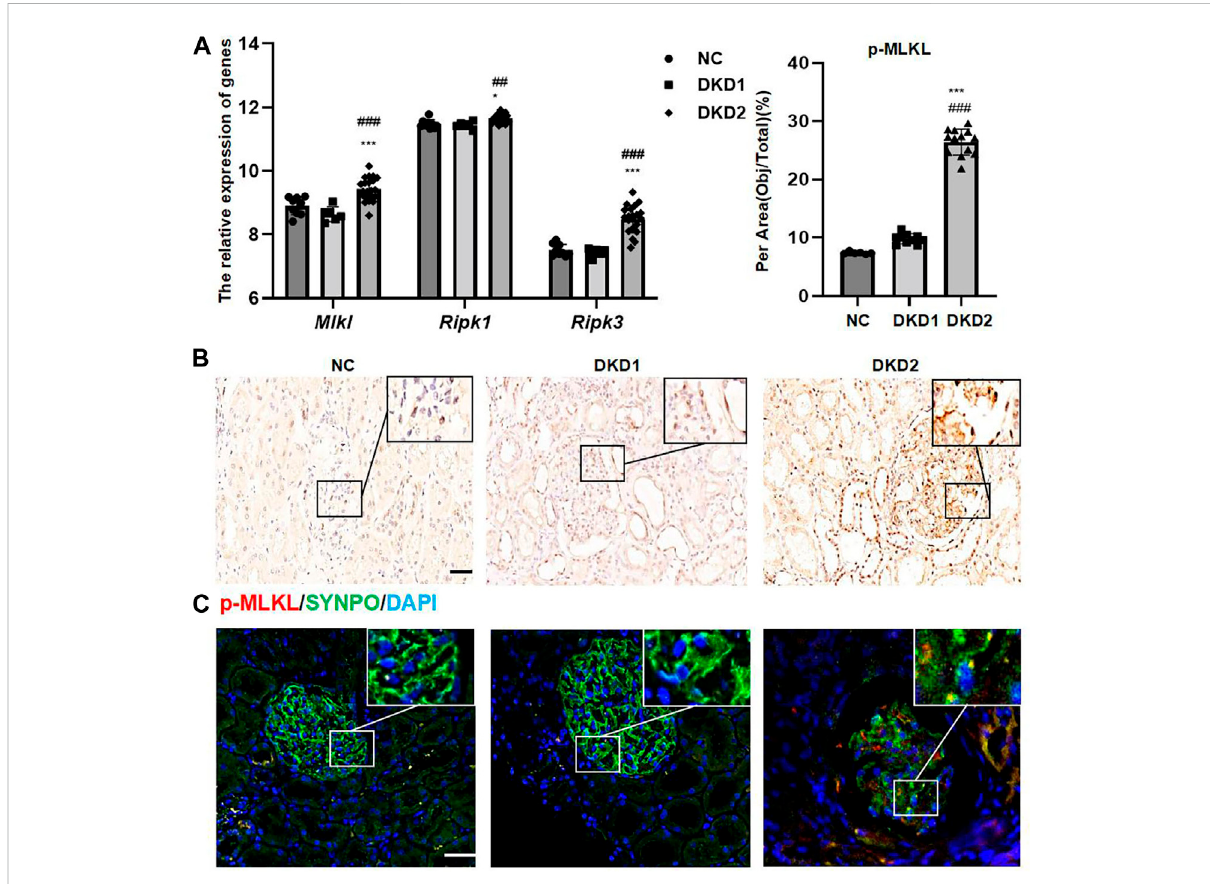
FIGURE 1 Necroptosis-related proteins changed in human kidney tissue with DKD. (A) The relative expression of necroptosis-related genes in GSE 142025. (B) IHC assay of p-MLKL protein expression in the glomerulus of human renal biopsy tissues. Scale bar = 20 μ m. (C) IF double staining for